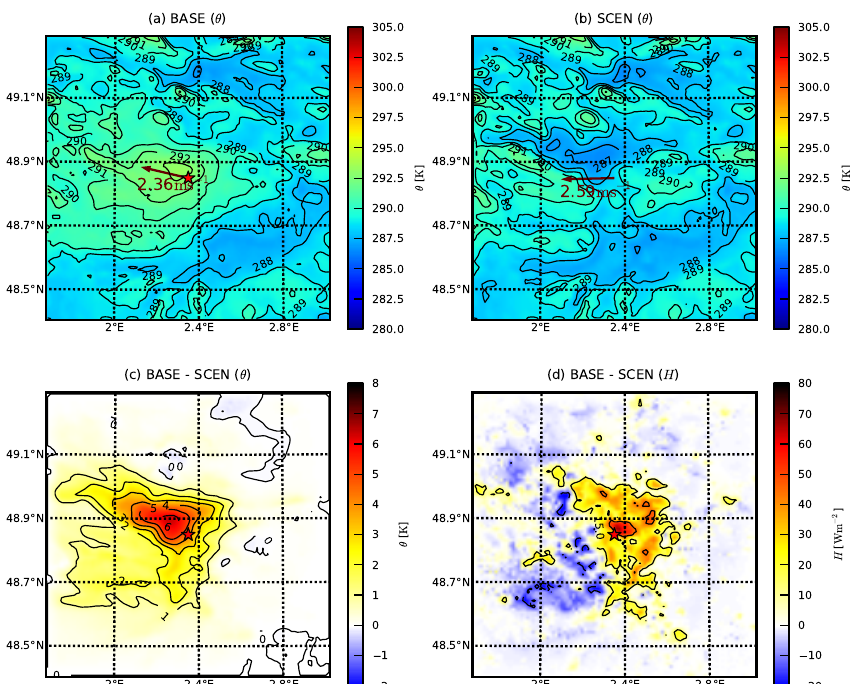
Fig. 7. The potential temperature in K over Paris at 23:00UTC at 12.5m for the base run (a) , scenario run (b) and the difference (c) . The difference in surface sensible heat between the base run and scenario run is given by (d) . The city centre is indicated with the red star and the horizontal wind with the red